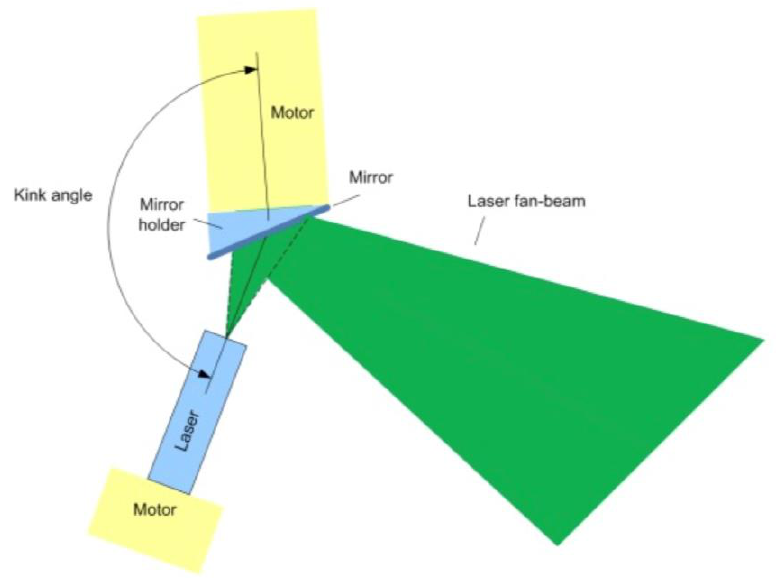
Figure 2. Schematic of a projector: each of the four projectors is comprised of a laser and a mirror. The orientation of the fan laser and the mirror can be adjusted by a rotation motor.